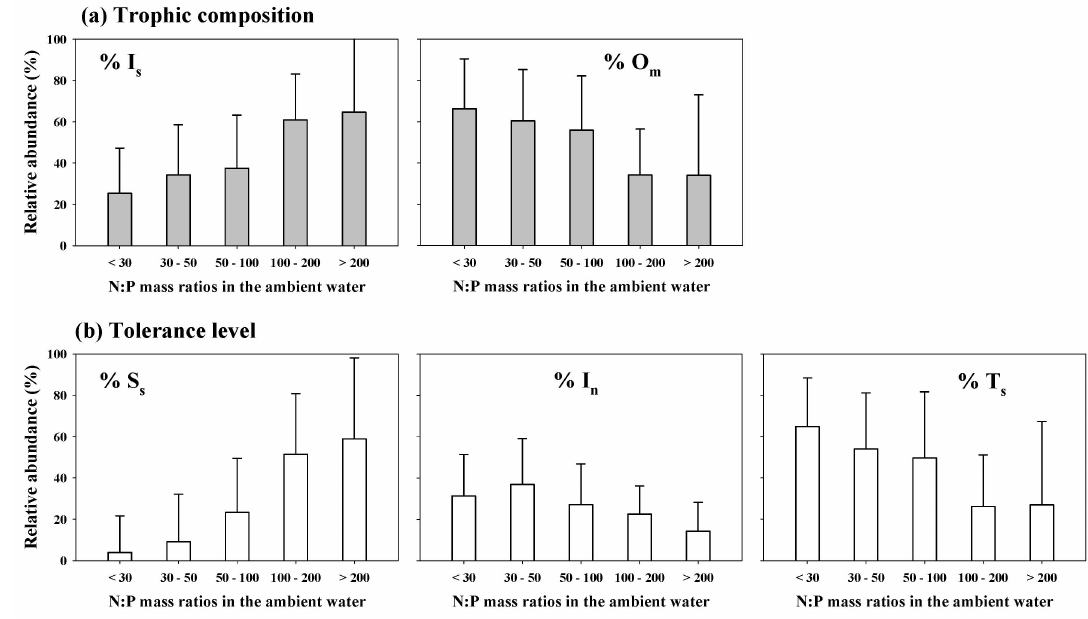
Figure 7. Mass ratios of the N:P interval in ambient water, in relation to means ˘ SE of ( a ) trophic composition (I s = Insectivore sp., O m = Omnivore sp.); ( b ) tolerance level (S s = Sensitive sp., I n = Intermediate sp., T s , = Tolerant sp.) in the Geum River watershed. % I s , proportion of insectivores; % O m , proportion of omnivores; % S s , proportion of sensitive species; % I n , proportion of intermediate species; % T s , proportion of tolerance